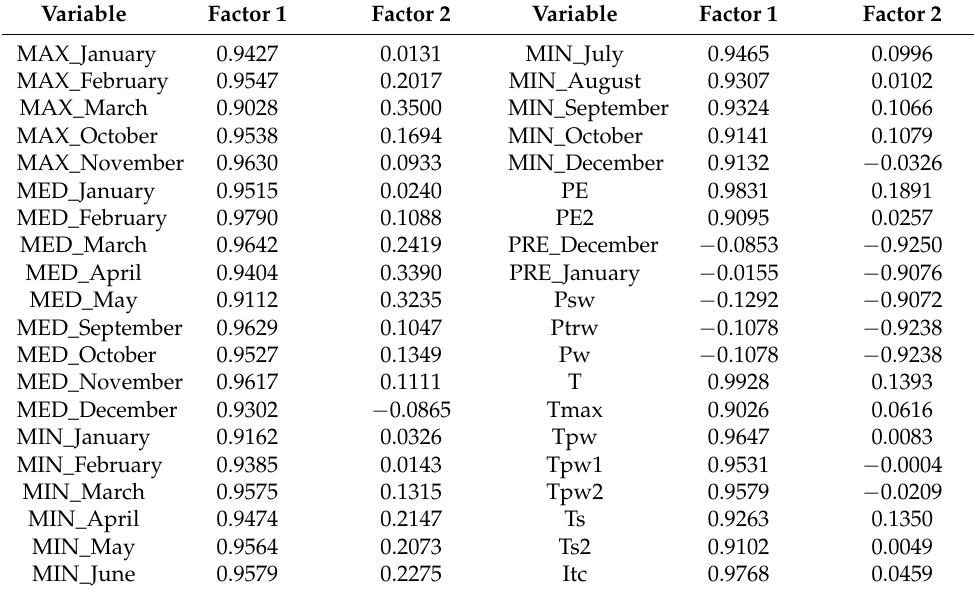
Table 1. Correlation between the climatic and bioclimatic variables with the two first rotated factors. (MAX = Mean maximum temperature of each month, MED = Mean temperature of each month, MIN = Mean minimum temperature of each month, PE = Thornthwaite annual potential evapo- transpiration index, PE = Thornthwaite annual potential evapotranspiration index for February, PRE = Precipitation, Psw = Precipitation of the coldest semester of the year, Pw = Precipitation of the winter quarter, T = Mean annual temperature, Tmax = Mean annual maximum tempera- ture, Tpw = positive temperature of the coldest four-month period, Tpw1 = positive temperature of the coldest month, Tpw2 = positive temperature of the two coldest months, Ts = mean sum- mer temperature, Ts2 = mean temperature of the two warmest summer months, Itc = compensated thermicity index. Variable Factor 1 Factor 2 Variable Factor